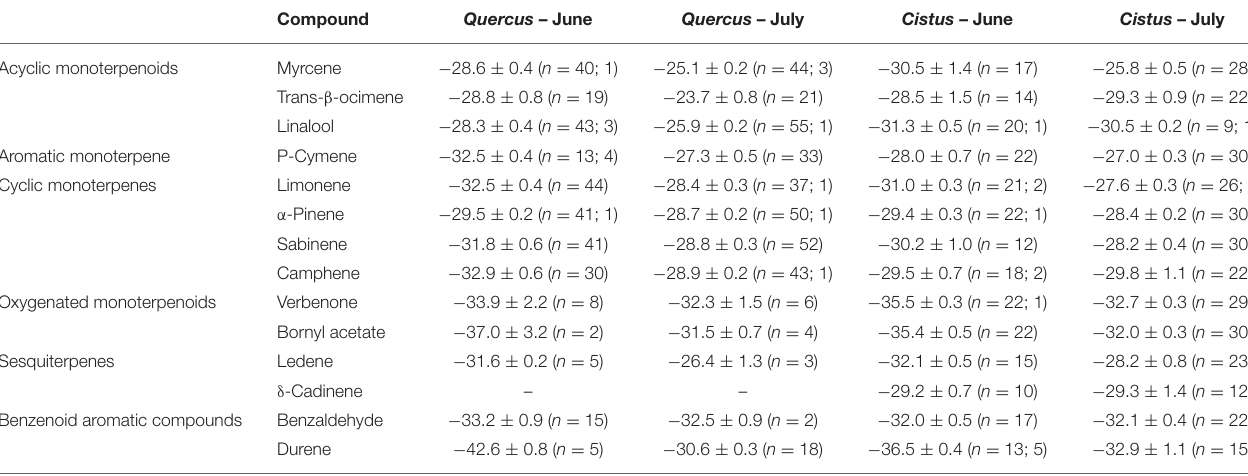
TABLE 2 | Average δ 13 C values for chosen BVOCs with standard error for Q. suber and C. ladanifer for June and July.